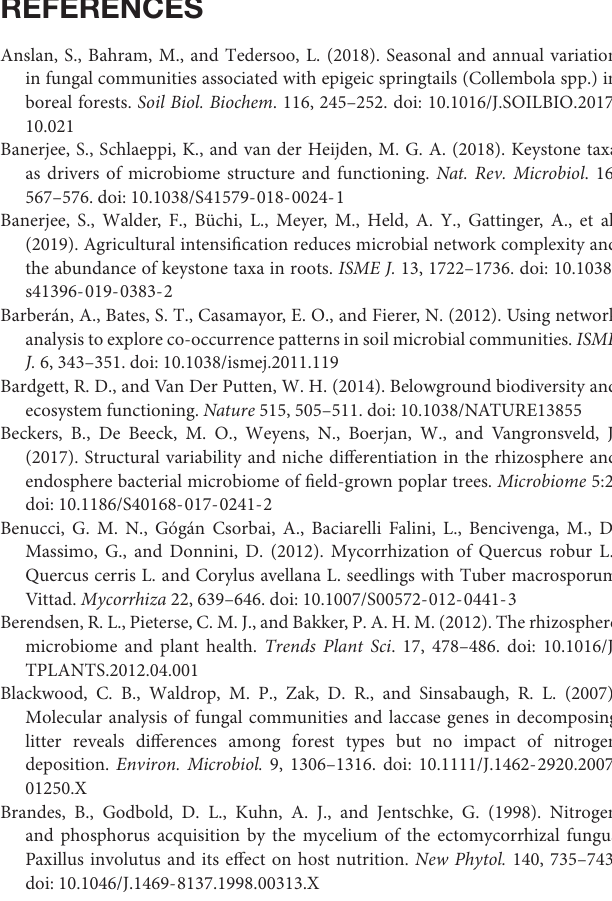
Supplementary Table 6 | Soil